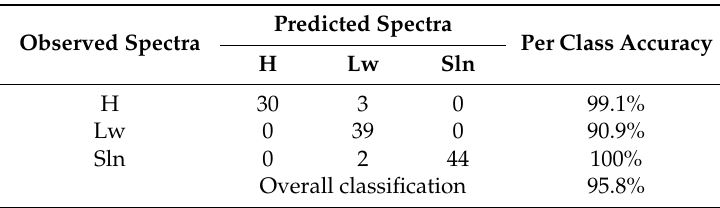
Table 3. Classification matrix obtained from the multilayer perceptron (MLP) neural network (for 2010) using 10 bandwidth data and healthy (H), laurel wilt (Lw), Phytophthora root rot (Prr) early stage.